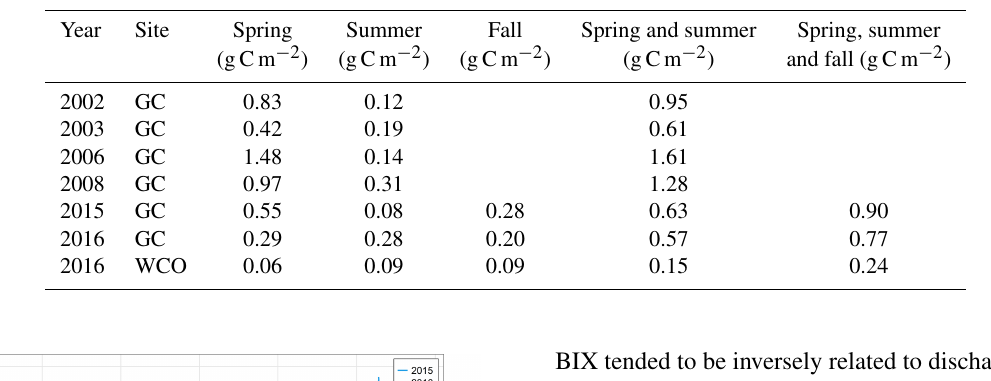
Table 2. Load estimates for GC and WCO for 6 years by individual season, spring and summer, and all relevant seasons combined (spring, summer and fall).